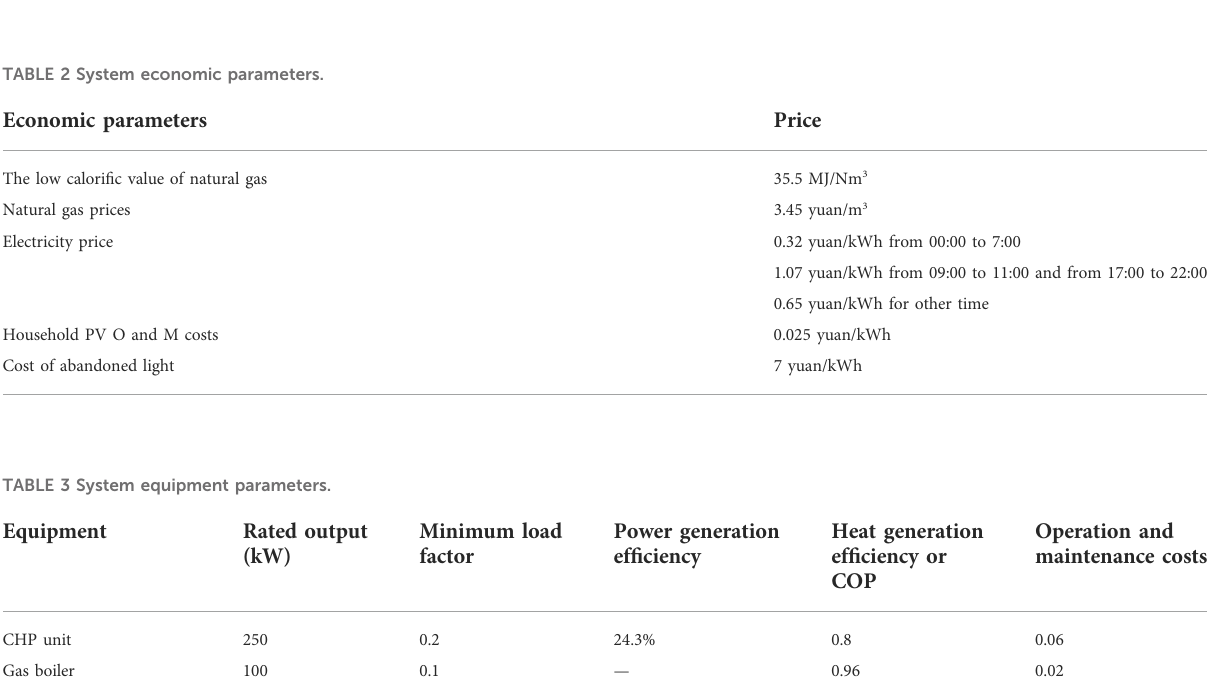
Table 6. It can be seen that all three scenarios correspond to a